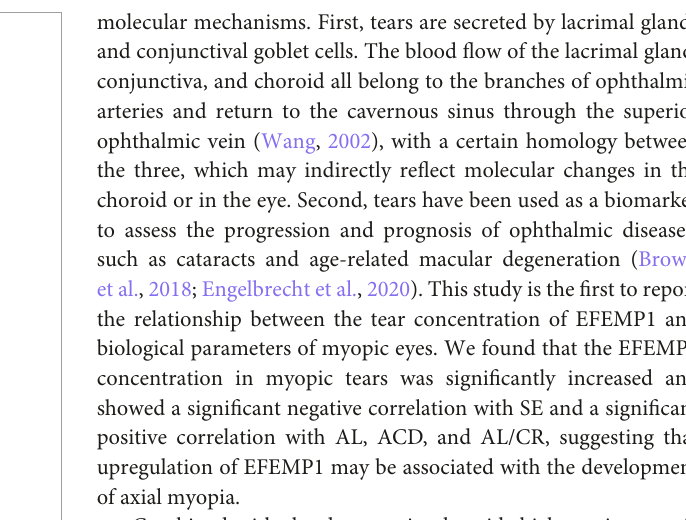
FIGURE7 Changes in right eye diopter and axial length in two groups. (A) Changes of refraction. (B) Changes of axial length. (C) Fundus of guinea pigs in control group. (D) Fundus of guinea pigs in FDM group. ∗∗∗ p < 0.001, compared with control group. FDM, form-deprivation myopia.